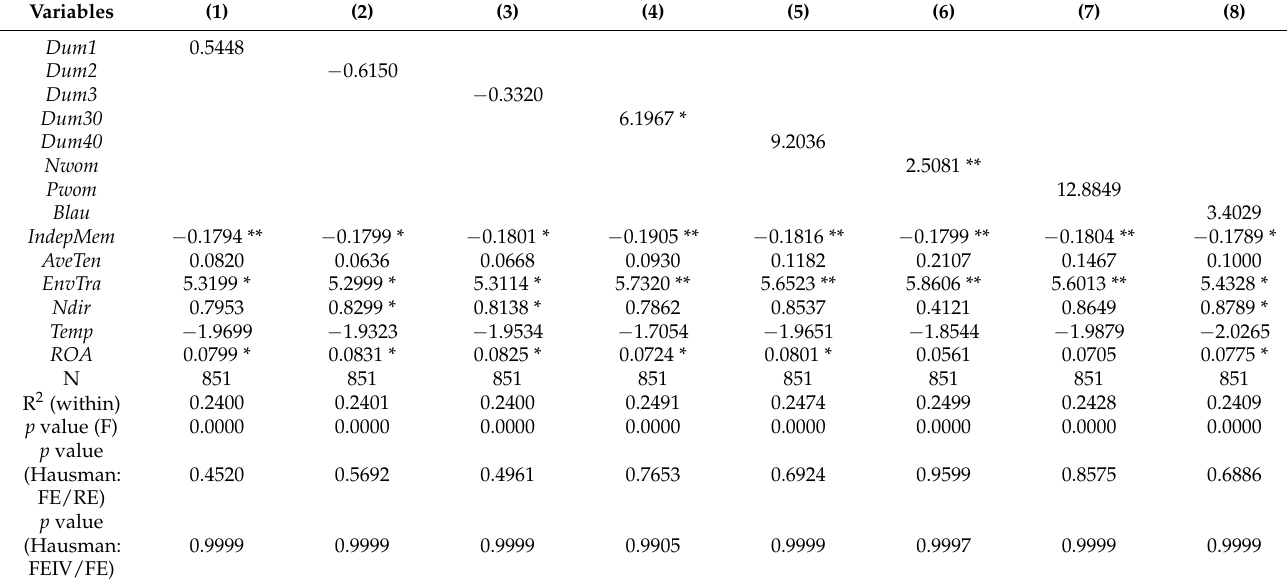
Table 10. Dependent variable: InnoSc . Fixed effects estimator